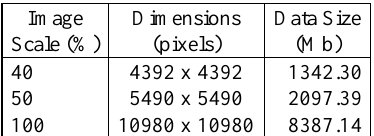
Table 1. Scaled versions of the original